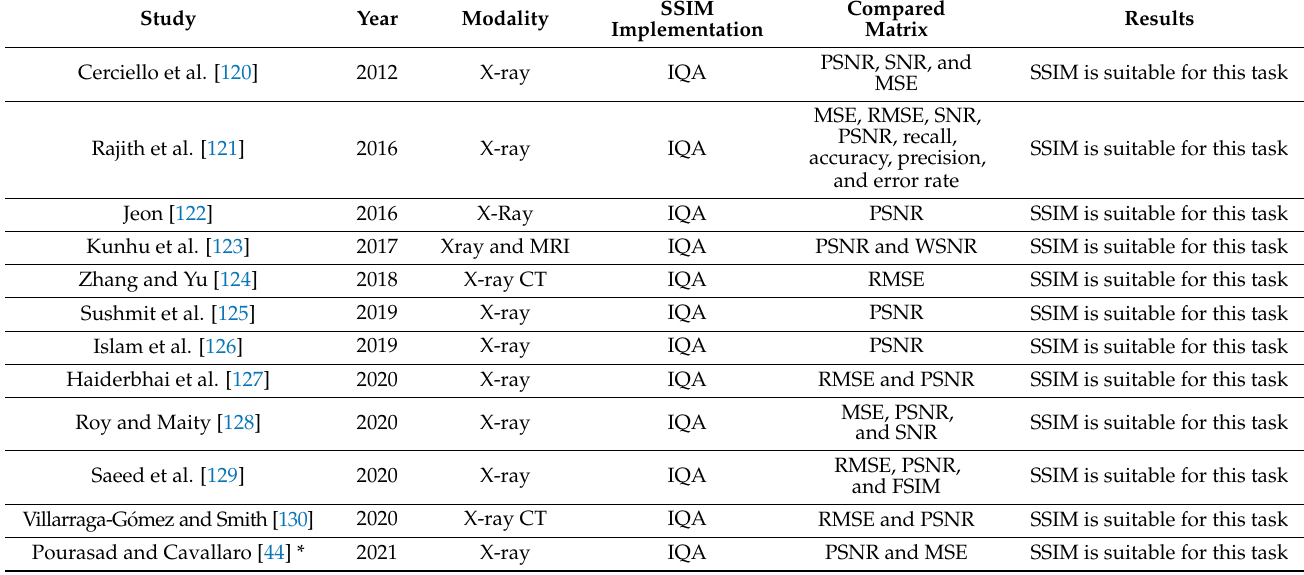
Table 4. Summary of the published articles encompassing SSIM for X-ray. PSNR, peak-signal-to-noise ratio; CT, computed tomography; MRI, magnetic resonance imaging; SNR, signal-to-noise ratio; MSE, mean-square error; RMSE, root-mean-square error; WSNR, wavelet domain signal-to-noise ratio; RMSE, root-mean-square error; FSIM, feature similarity